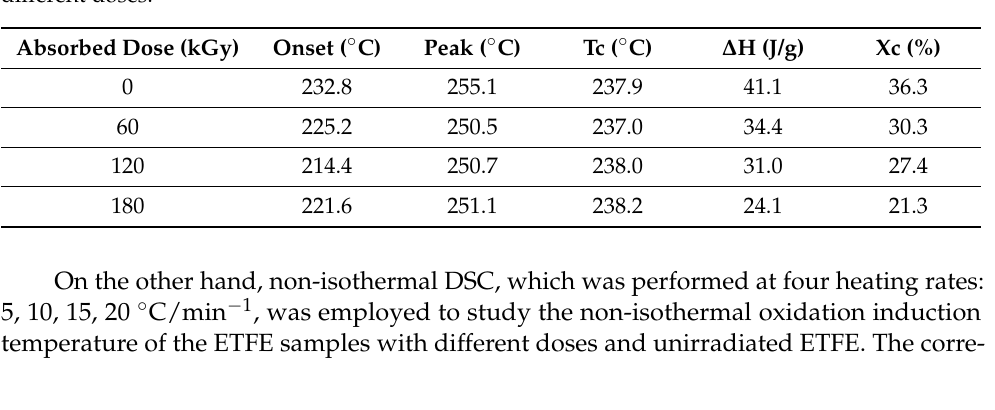
Figure 4. Typical melting thermograms of unirradiated ethylene-tetrafluoroethylene copolymer (ETFE) and irradiated ETFE at various doses. Table 1. Non-isothermal differential scanning calorimeter (DSC) scans results for the samples at different doses.